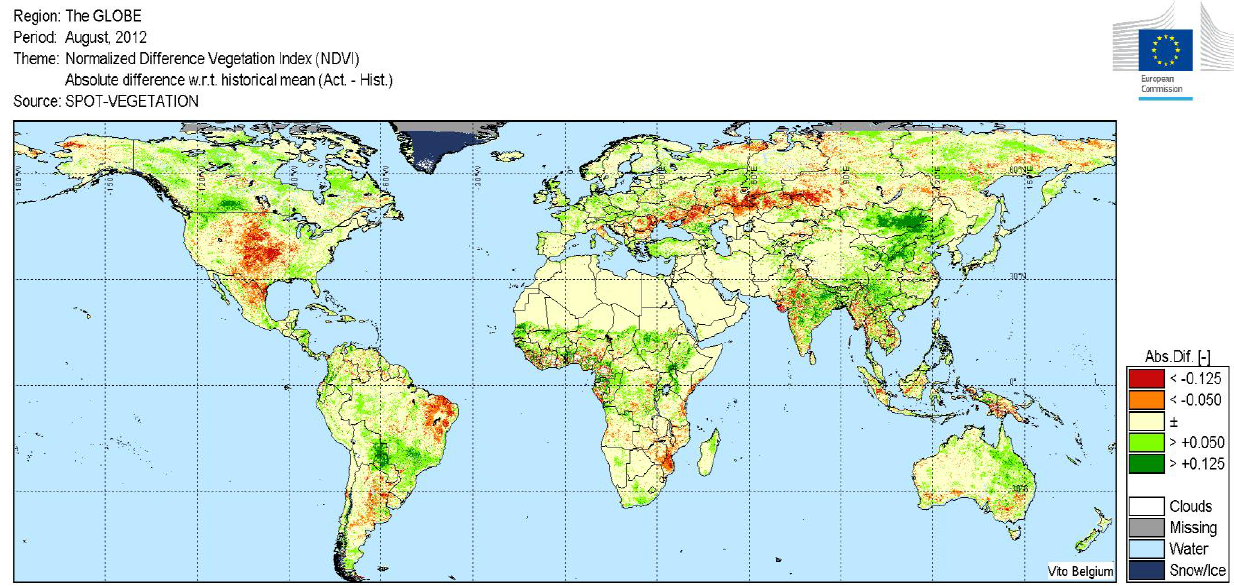
Figure 2. Global map of NDVI anomalies during the 2012 growing season (August). Negative anomalies are visible mainly in central US, central Asia and northern Brazil, while a positive situation is evident in eastern China and southern Brazil. Data are from SPOT VEGETATION (as compared to 1999–2010 average). Anomalies are expressed in absolute NDVI